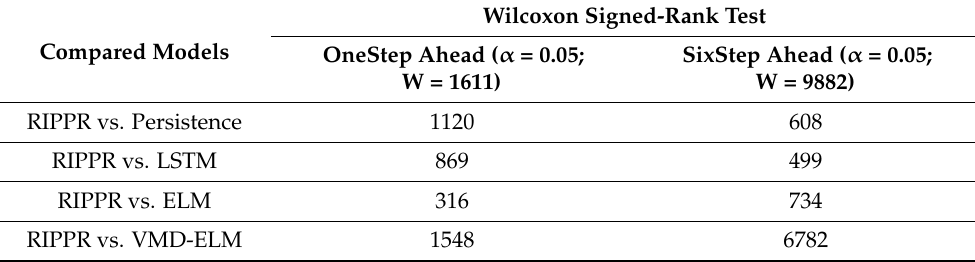
Table 3. Wilcoxon signed-rank